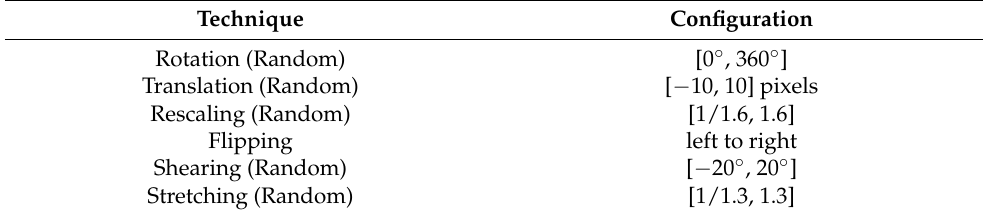
Table 2. Various configurations of the image augmentation method.